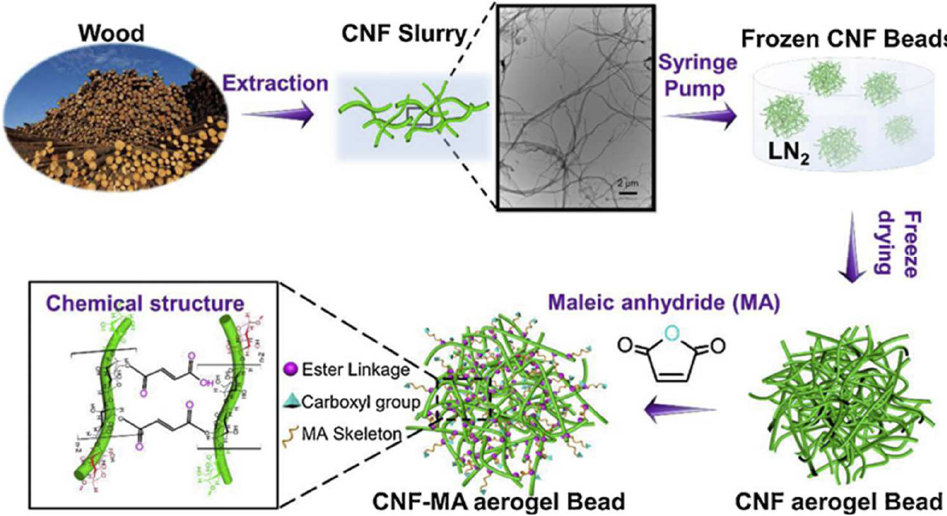
Figure 5. Schematic illustration of the preparation process and proposed chemical structure of the CNF-MA beads. Adapted with permission from [52]. Copyright 2019 Elsevier. Table 2. Preparation method and properties of carboxyl-containing nanocellulose.